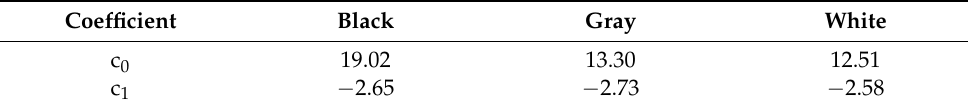
Table 11. Optimal coefficients for fitting the